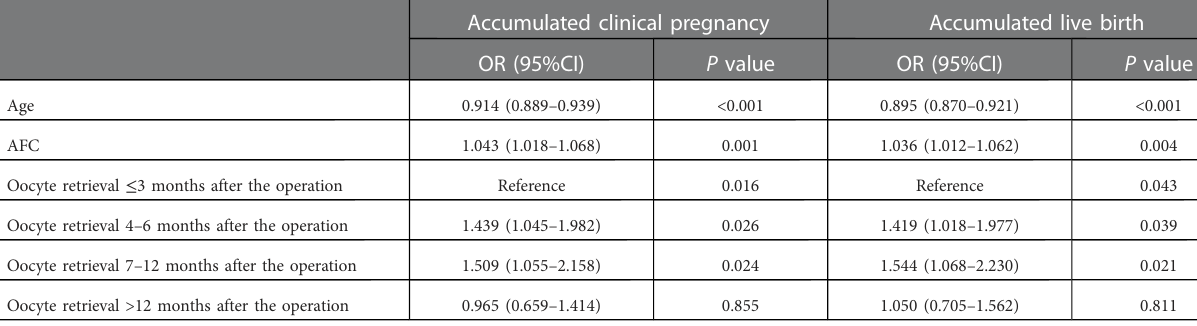
TABLE 4 Logistic regression analysis of factors associated with pregnancy